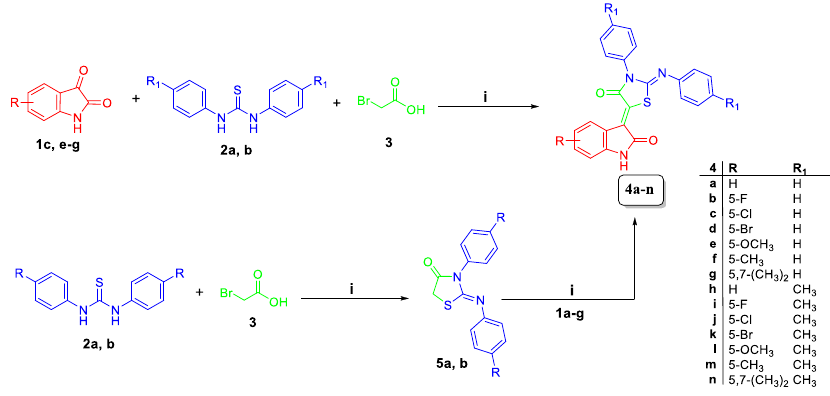
Figure 1. Structures of isatin-based approved anticancer drugs ( II & III ), some reported